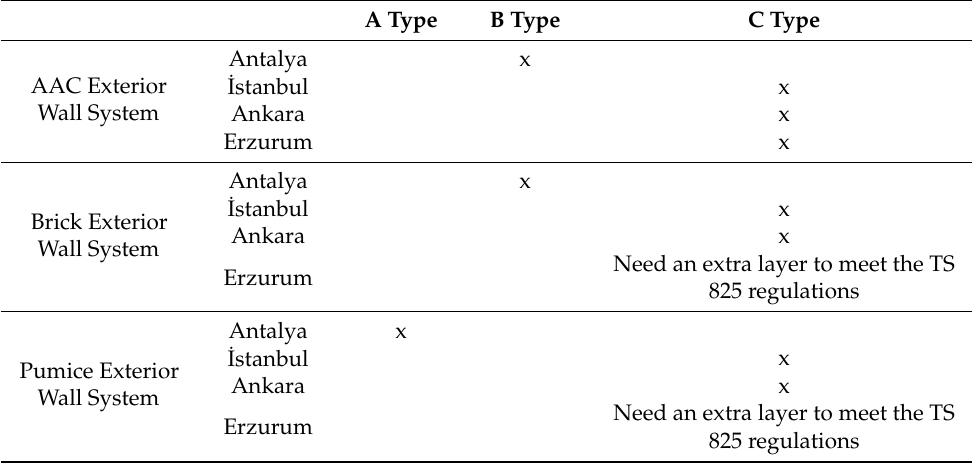
Table 9. Building energy efficiency